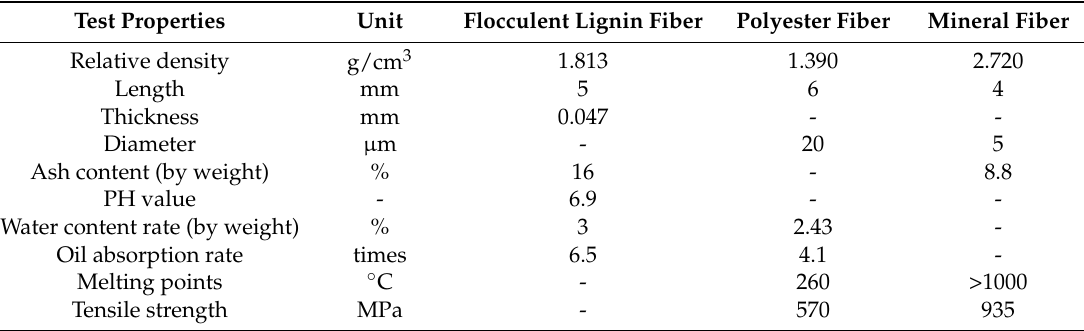
Table 5. Technical indicators of different